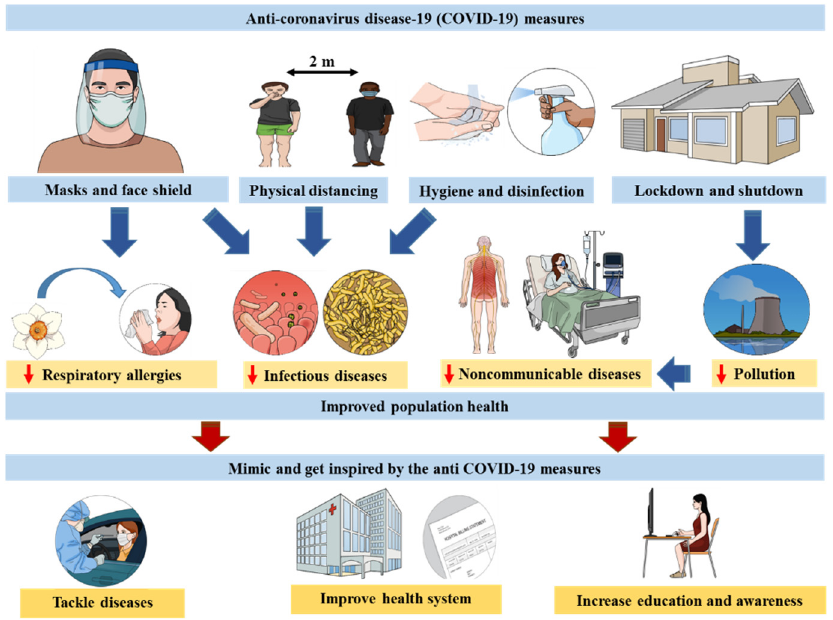
Figure 1. The positive outcomes of the measures taken to limit COVID-19 spread represent “side effects” of these measures. Yet, they are worth describing in order to use the related conclusions towards improving various aspects of health care.